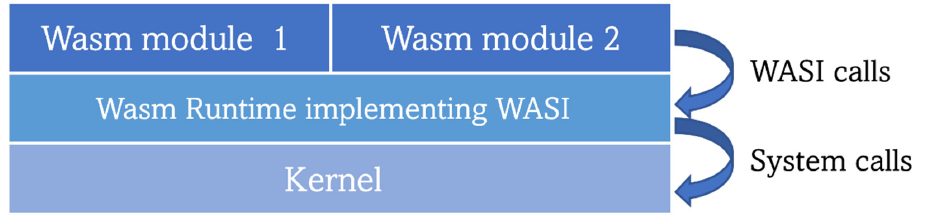
Figure 6. Architecture for running WebAssembly workloads on the server side.